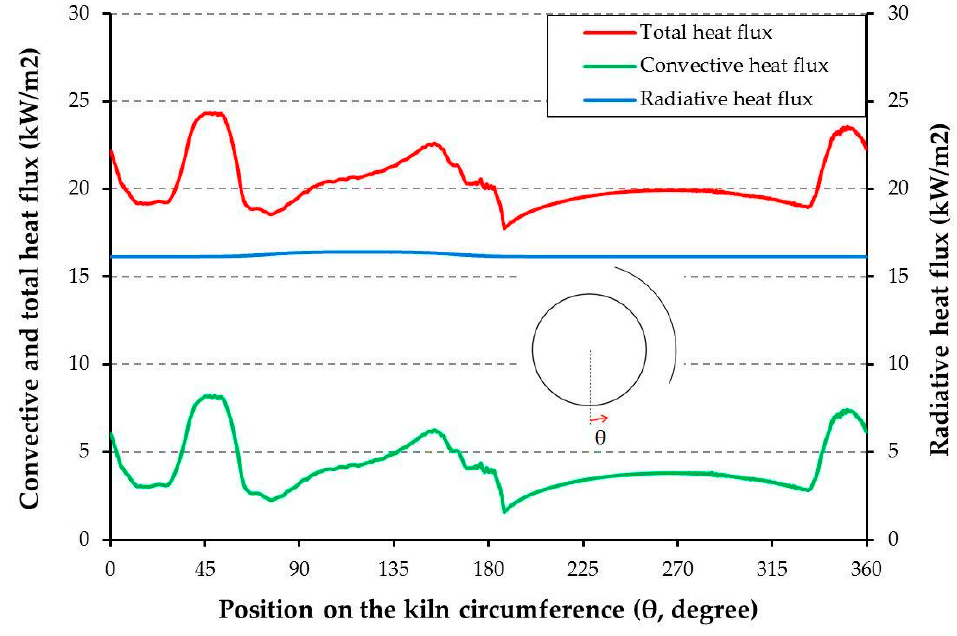
Figure 5. Time-averaged local convective, radiative, and total heat flux around the kiln surface while temperature of the kiln is constant.